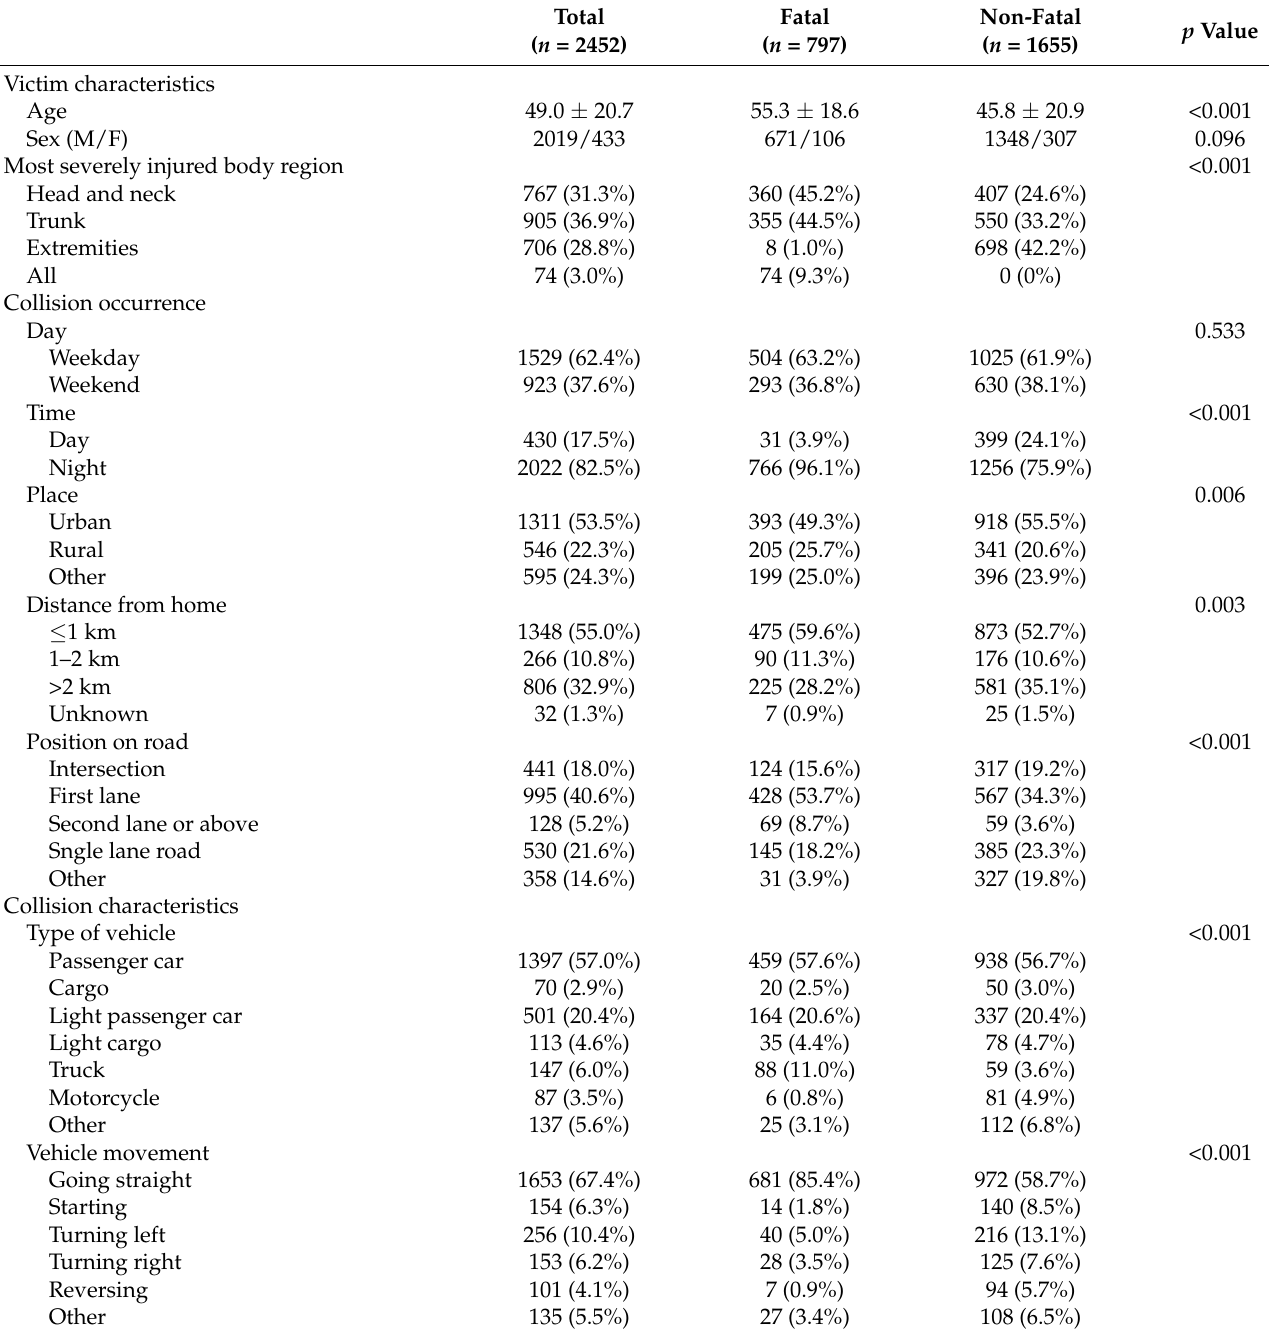
Table 1. Victim and collision characteristics for fatal and non-fatal collisions. Total ( n = 2452)